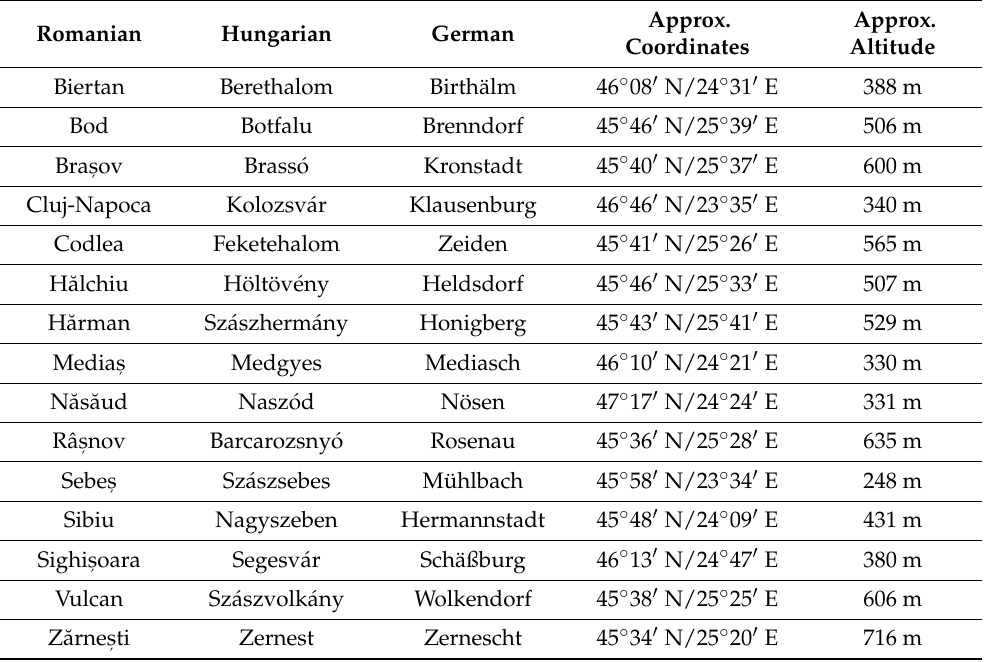
Table 1. List of localities mentioned in the text, given with their names in the three major spoken languages of the country and their approximate coordinates and